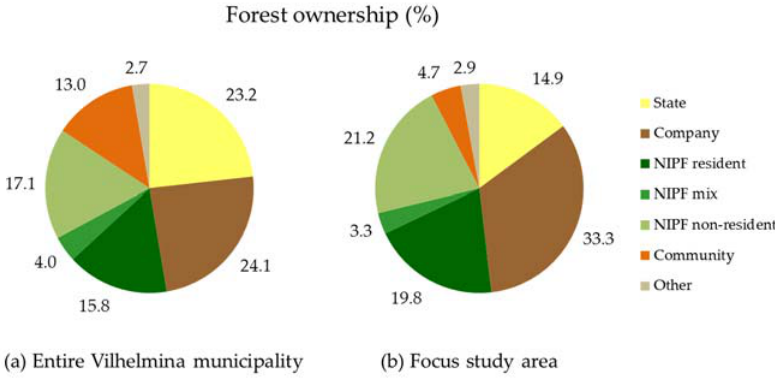
Figure 3. The distribution of forest lands by owner categories for ( a ) the entire Vilhelmina municipality (Sweden) and ( b ) for our focus study area as of January 2016. Land ownership is categorized into State, Company (large-scale forest companies), NIPF resident and NIPF non-resident (non-industrial private forest owners identified as living in or outside the municipality), NIPF mix (a mix of NIPF resident and NIPF non-resident owners), Community (a large forest common, the municipality and some smaller village commons), and Other (the church, foundations, and unidentified owners).